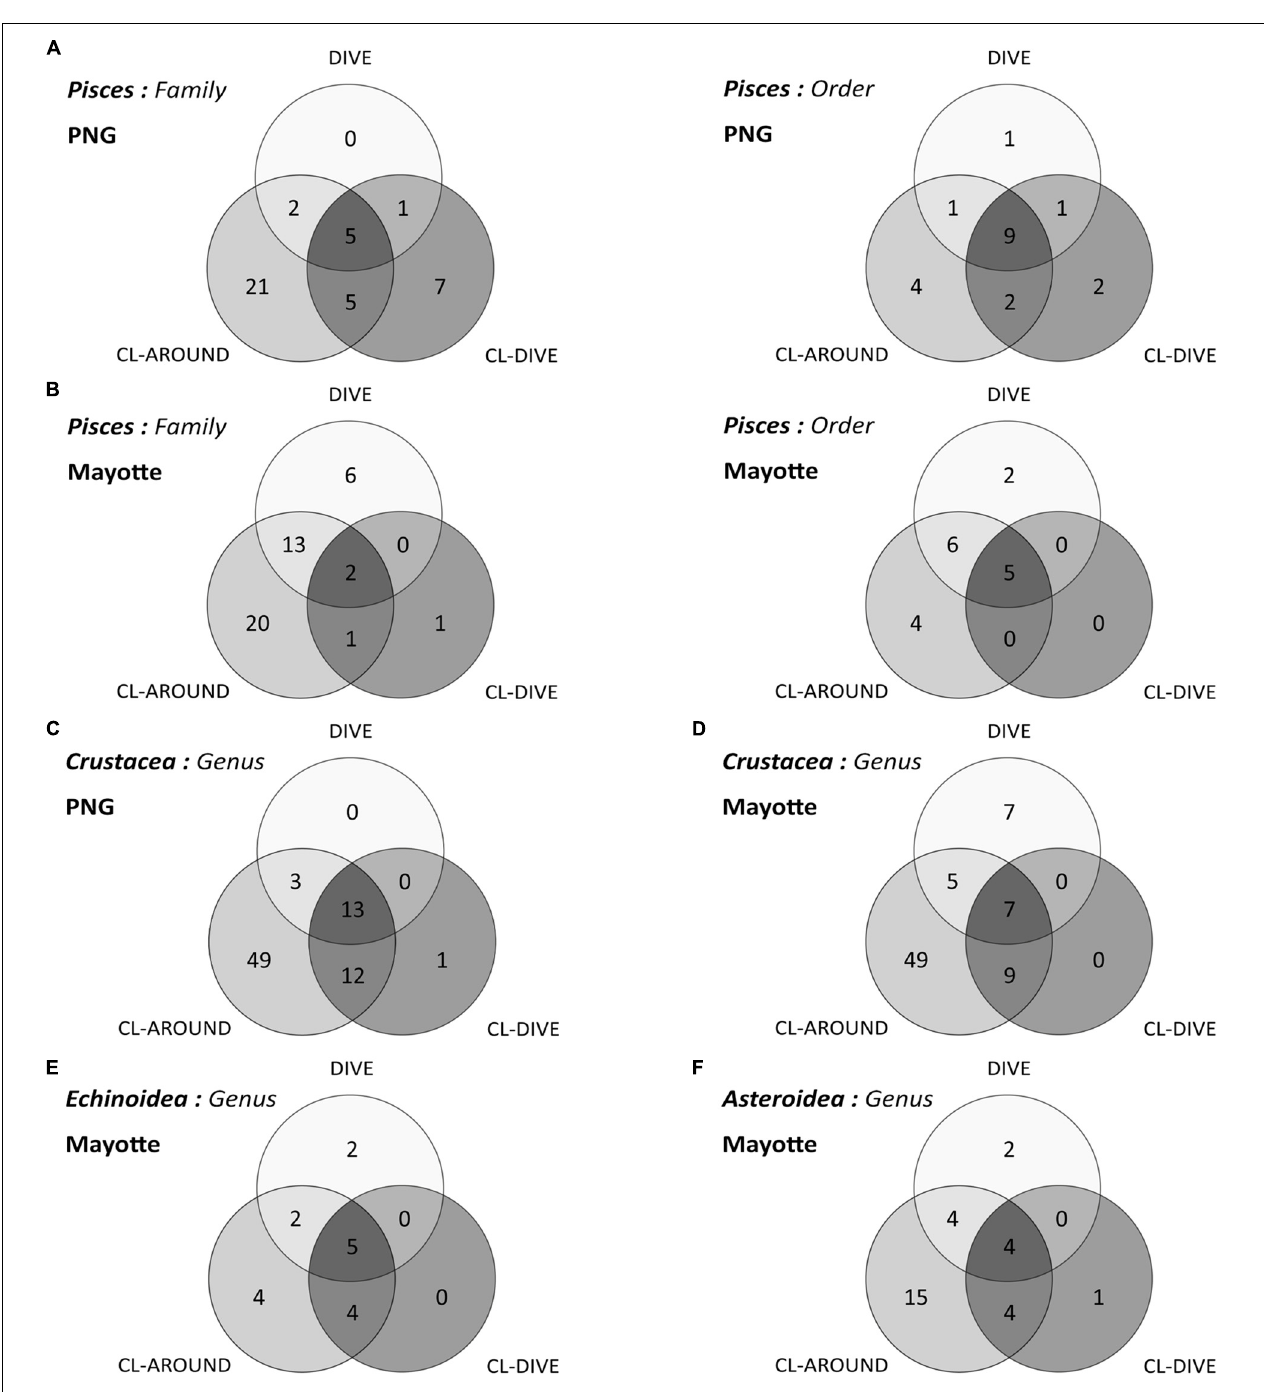
FIGURE 6 | Venn diagrams of taxonomic richness captured and identified from images (dive), sampling along dive (cl-dive) and in the surrounding area (cl-around): (A) Pisces at order and family ranks along sedimented slope habitats (PNG) and (B) along volcanic island slopes (Mayotte); (C) Crustacea at genus rank in PNG and (D) in Mayotte; (E) Echinoidea at genus rank in Mayotte; (F) Asteroidea at genus rank in Mayotte. In each circle the sum of numbers represents a taxonomic rank captured (e.g., number of order or family, etc.).